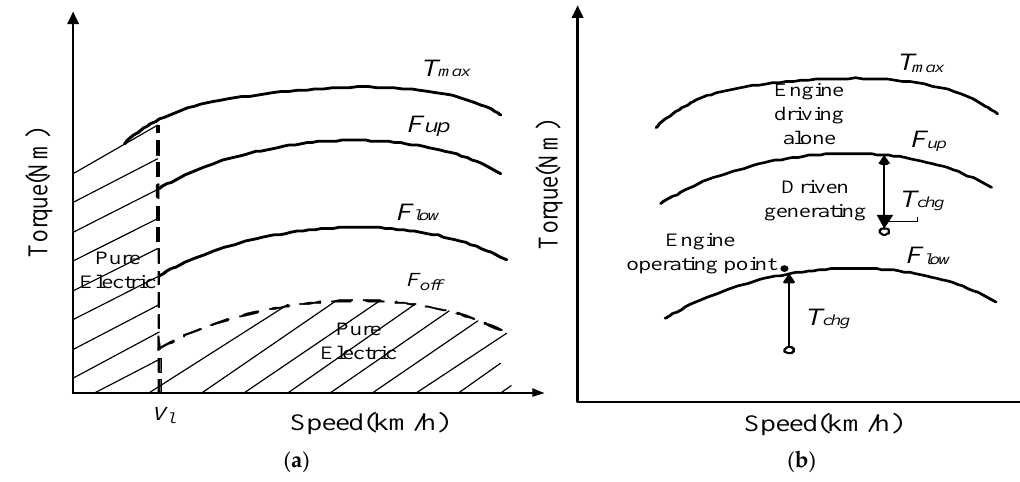
Figure 2. Logic diagram of control strategy. ( a ) SOC > SOC low ; ( b ) SOC ≤ SOC low .